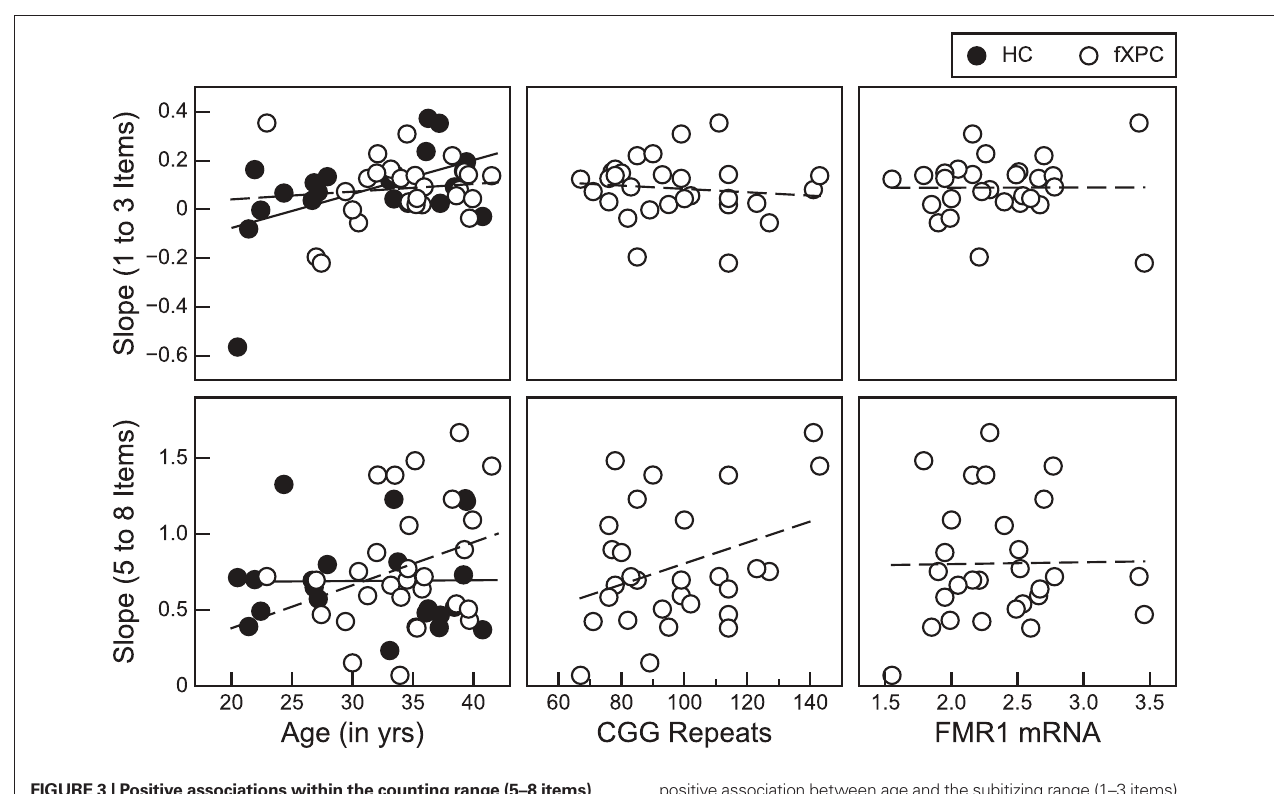
FiguRe 3 | Positive associations within the counting range (5–8 items) were observed for female fXPCs: one between age and slope, which approached significance [ p (one-tailed) = 0.06] and one between Cgg repeat length and slope, p (one-tailed) = 0.03. There was only one